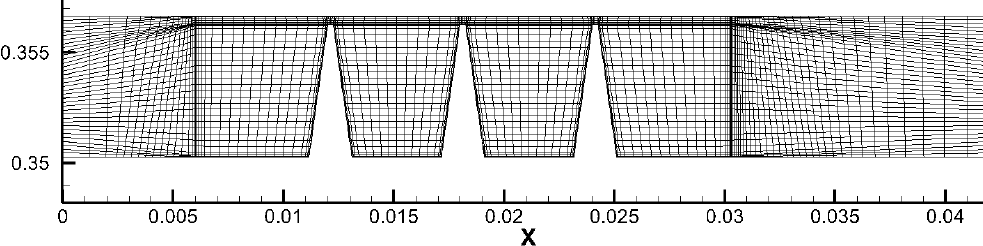
Figure 3. Computational mesh of CAM.